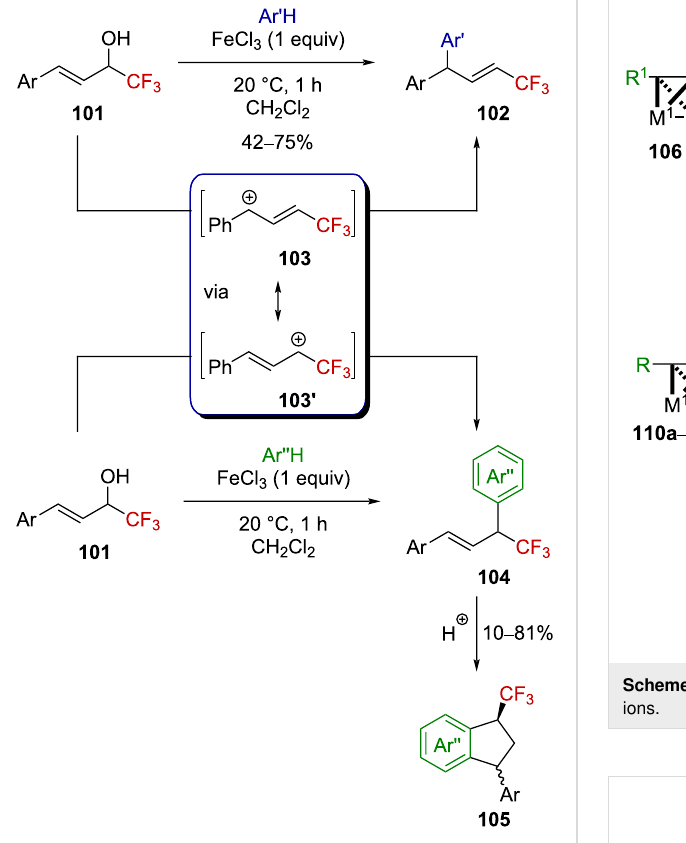
Scheme 29: Lewis acid activation of CF 3 -substituted allylic alcohols.